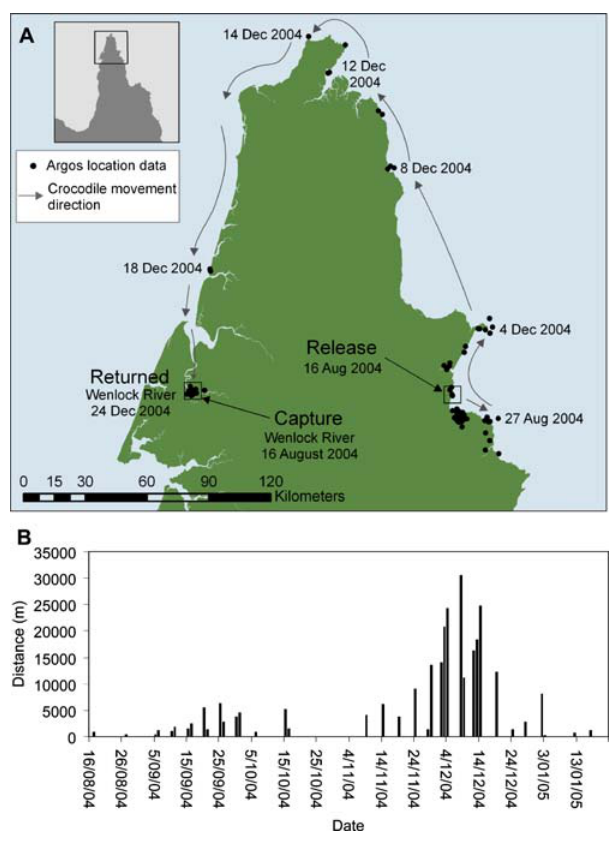
Figure 3. Movement patterns of the translocated estuarine crocodile that circumnavigated Cape York Peninsula. A Map and location fixes of Crocodile C captured in the Wenlock River on the west coast and flown across Cape York Peninsula and released into the ocean on east coast. B Daily distances covered (m) by Crocodile C after release.